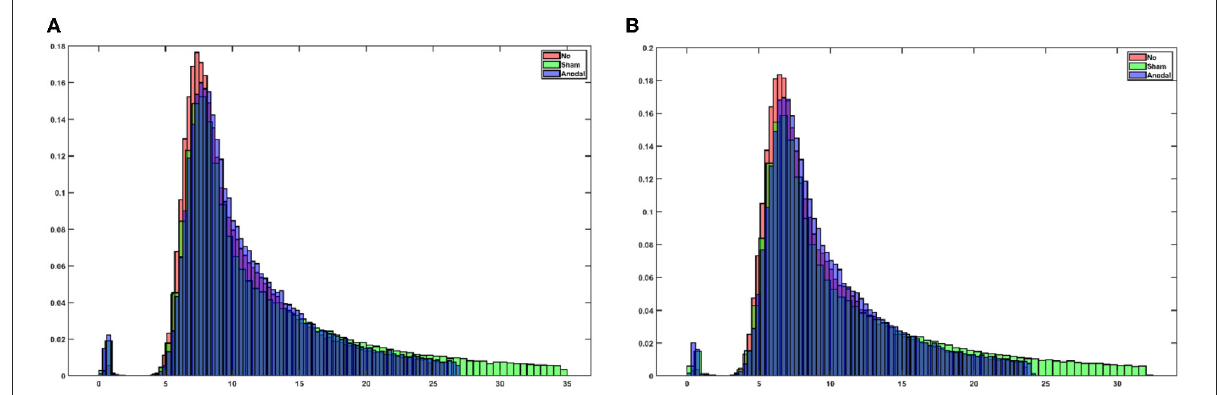
FIGURE2 (A) An estimation of the probability density function across all voxels for the height parameter (in the x -axis) of the HRF using canonical HRF with time and dispersion derivatives. (B) Estimation of the probability density function across all the voxels for the height parameter (in the x -axis) of the HRF using the finite impulse response (FIR)